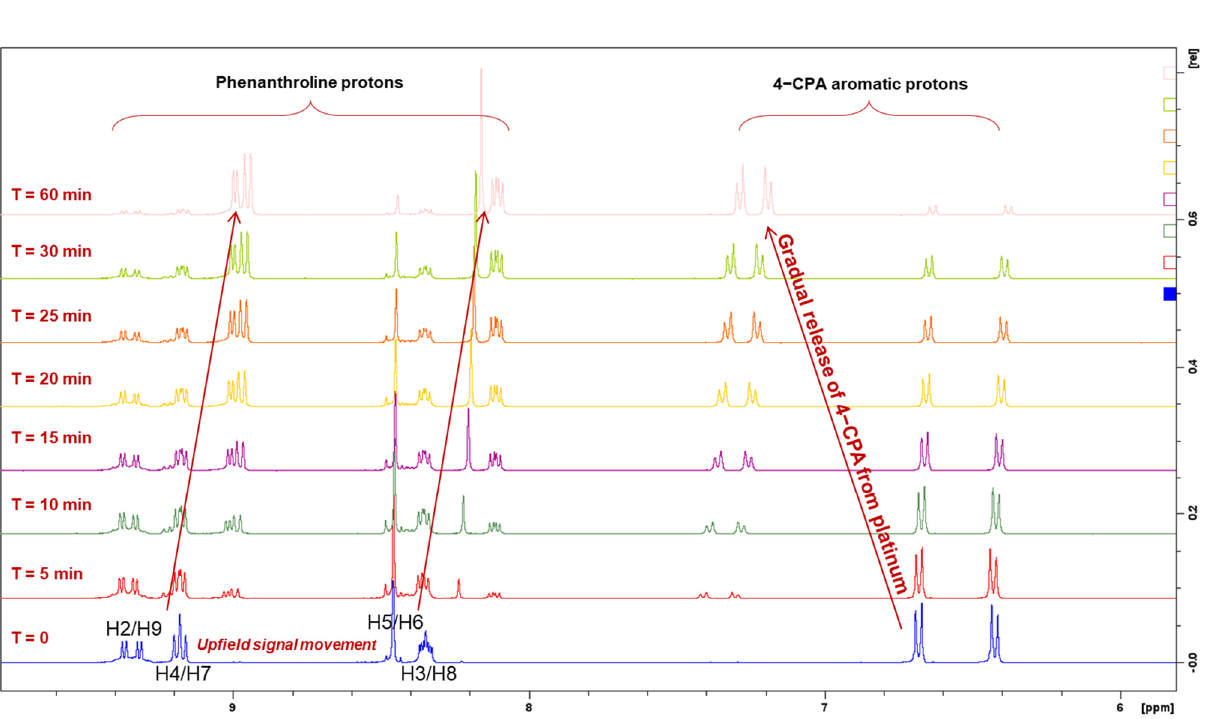
Figure 15. Zoomed 1 H − NMR spectra of 1 with PBS and AsA in D 2 O at 37 °C, in different time intervals, highlighting the movement of resonances from the phen protons and the aromatic protons of the 4 − CPA ligand as indicated by the red arrows. T represents time in min.